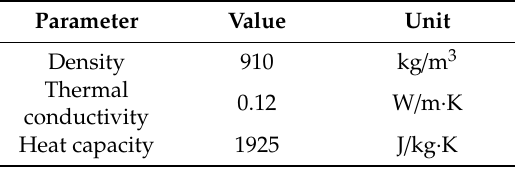
Table 2. Thermo-physical of polypropylene